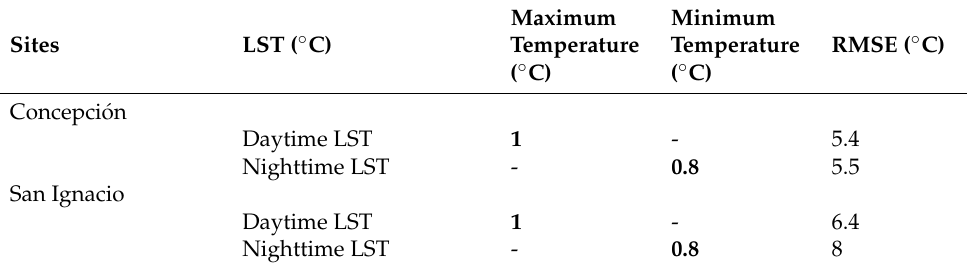
Table 6. Pearson correlation (r) and Root Mean Square Error (RMSE) between the monthly averages for LST and the air temperatures of the meteorological stations (Concepci ó n and San Ignacio). The highest correlations are highlighted in